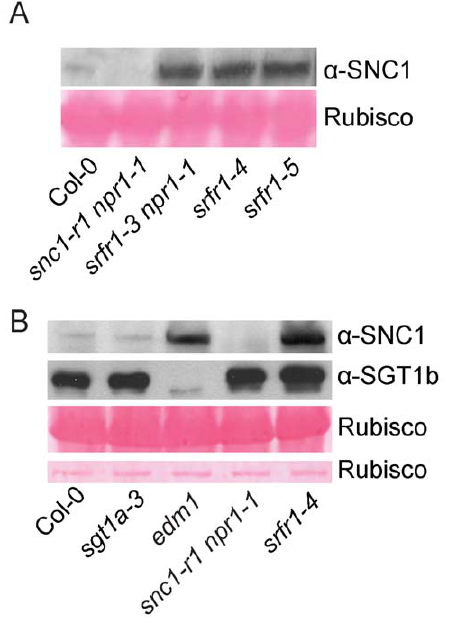
Figure 6. SNC1 protein levels in srfr1 mutant plants. (A) Western blot analysis of SNC1 protein levels in total protein extracts of wild type (Col-0), snc1-r1 npr1-1 , srfr1-3 npr1-1 , srfr1-4 and srfr1-5 . (B) Western blot analysis of SNC1 protein levels in total protein extracts of wild type (Col- 0), sgt1a-3 , edm1-1 ( sgt1b ), snc1-r1 npr1-1 and srfr1-4 .